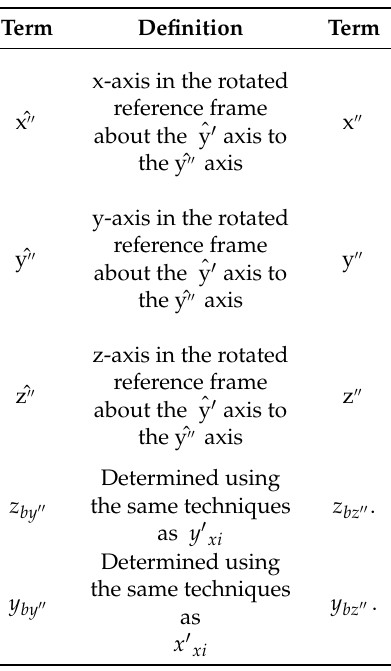
Figure 17. 1-rotation about the x”̂ and 𝑥 𝑏 ̂ axes to develop P’s coordinates in the new reference frame with all similar angles, shapes and equations established in Figures 7 – 15. Table 5. Proximal variable and nomenclature definitions for Figure